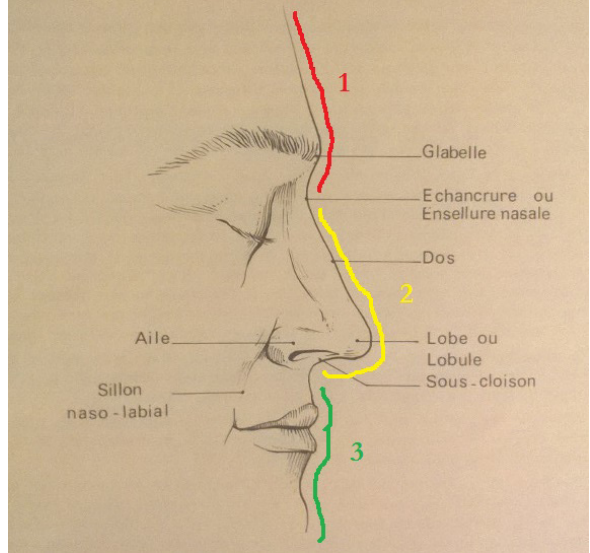
Figure 3. Points of variation for the face (from Pales, 1976).